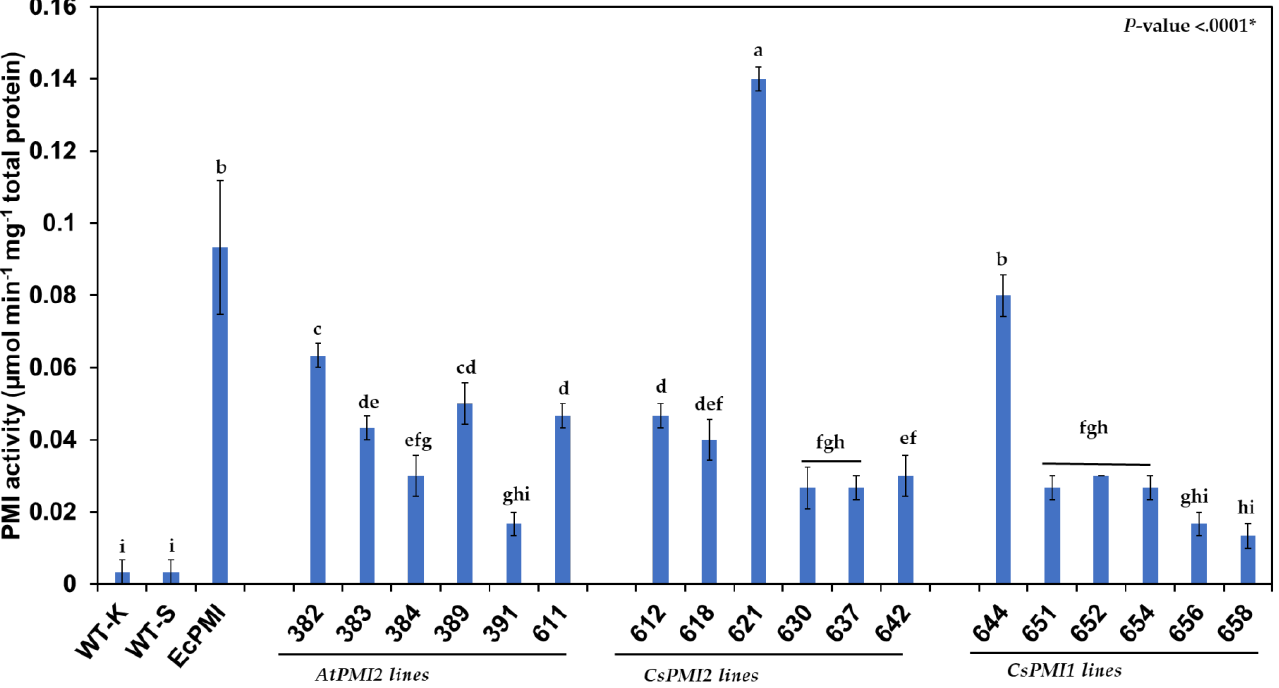
Figure 5. Quantitative analysis of total phosphomannose isomerase (PMI) activity in citrus leaves. WT-K, non-transgenic mature Kuharske; WT-S, non-transgenic Swingle; EcPMI, positive control of transgenic Swingle obtained from another project; lines 382, 383, 384, 389, 391, 611 are the AtPMI2 transgenics; lines 612, 618, 621, 630, 637, 642 are the CsPMI2 transgenics; lines 644, 651, 652, 654, 656, 658 are the CsPMI1 transgenics; six independent transgenic lines of mature Kuharske citrange were randomly selected and examined from each construct, three replicates from each plant. The test was repeated twice. Bars represented the Mean ± Standard Error (SE) of three technical replicates. Means followed by the same letter were not different at p ≤ 0.05 using Student’s t -test.3.5. Confirmation of PMI Expression Using Chlorophenol Red Assay.